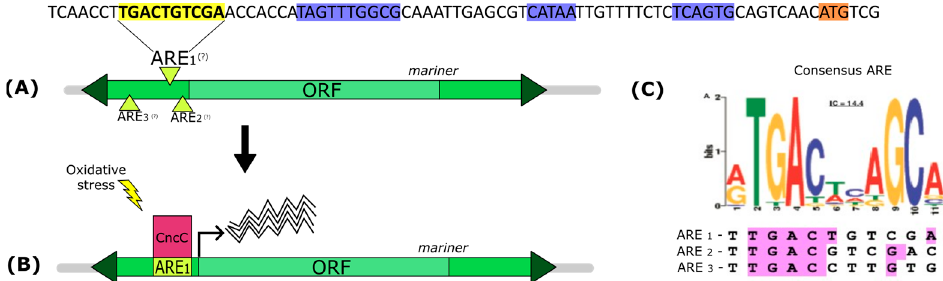
Figure 5. Promoter region of the mariner transposase gene. ( A ) The sequence highlighted in yellow is the putative binding site ARE (Antioxidant Responsible Element). The start codon is shown in orange and the core promoter elements are represented in blue. ( B ) The transcription factor CncC binds to the putative ARE binding sequence of mariner when exposed to oxidative stress, which increases the expression of the mariner transposase gene. ( C ) The logo of the consensus sequence ARE [41] and the three similar sequences to “ARE” found in the 5’ UTR region of mariner . Only “ARE 1” was statistically significant ( p = 6.4 × 10 − 5 ) .